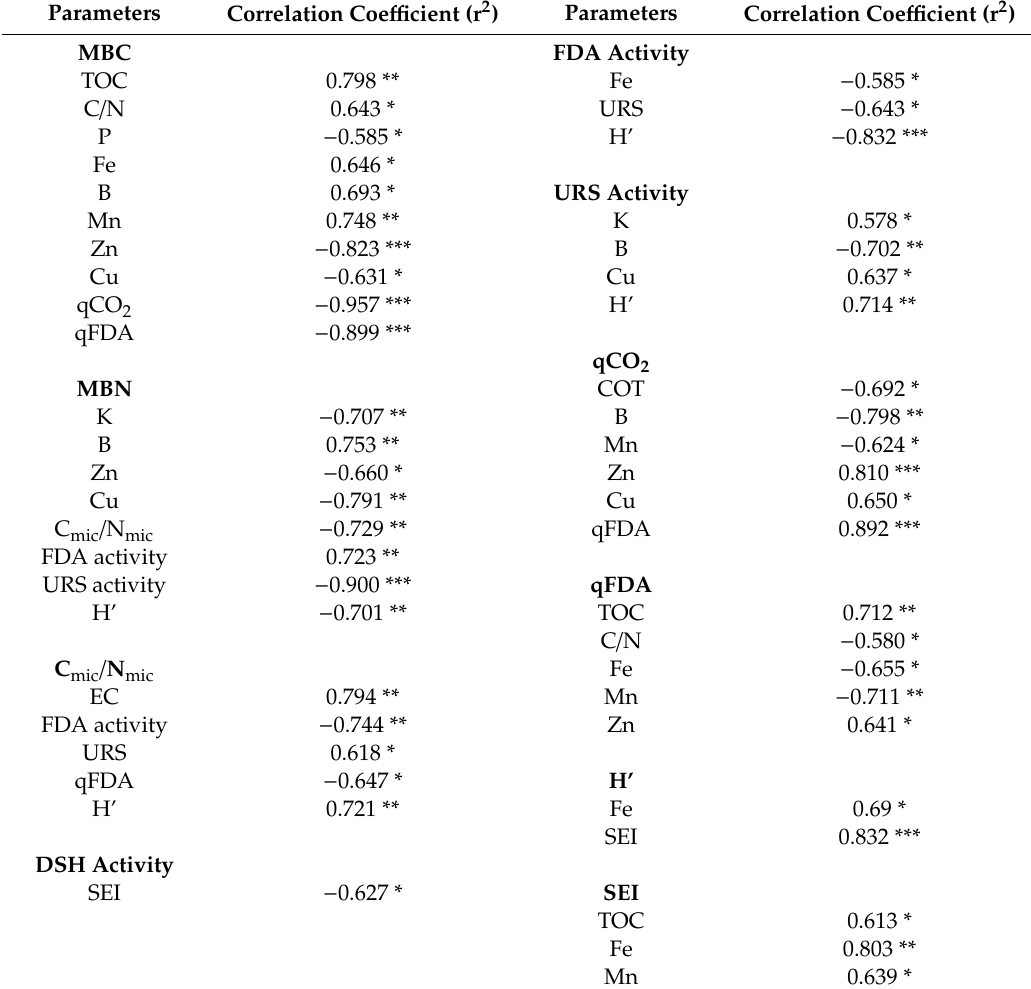
Table 5. Pearson’s product moment correlation coe ffi cient between biological and physicochemical parameters in the biosolids collected and evaluated in the UWWTP at di ff erent season of the year.